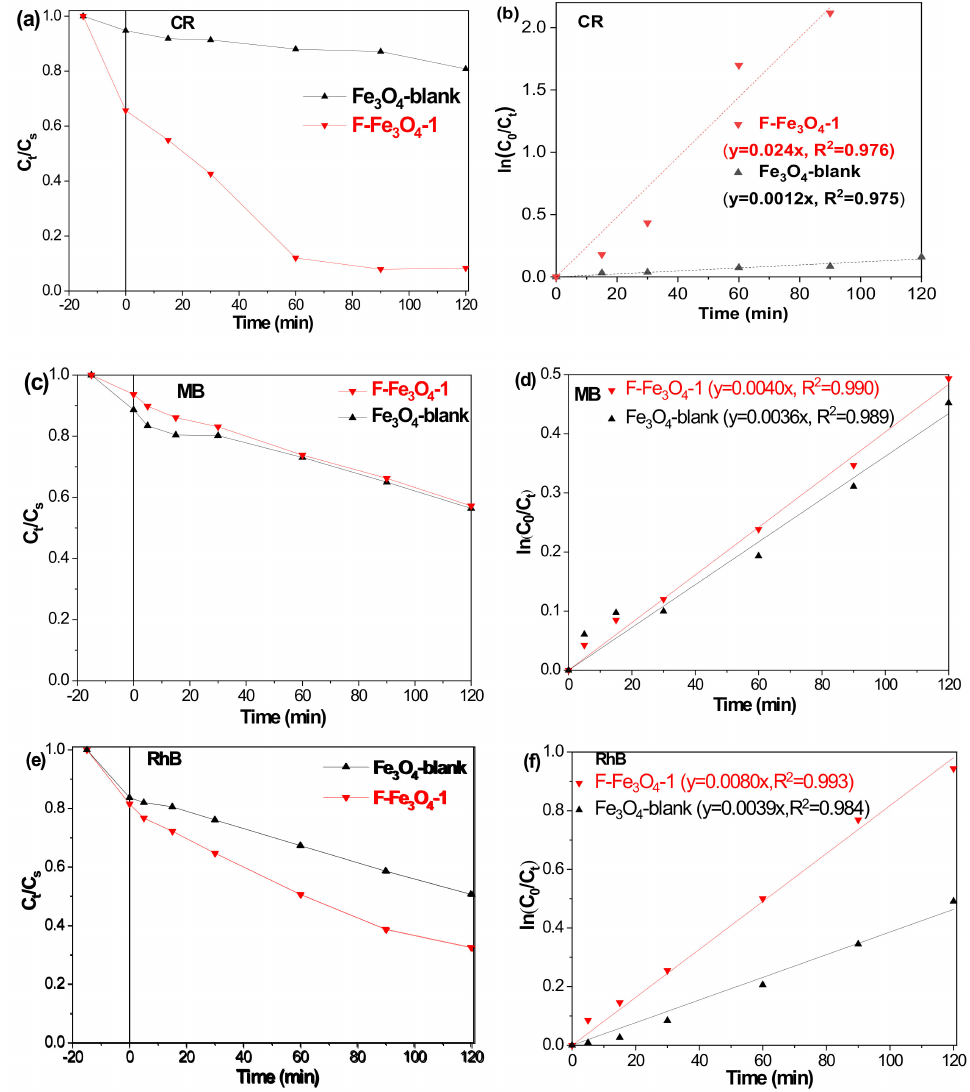
Figure 3. CWPO of organic dyes over F-Fe 3 O 4 -r (r = 0 and 1) microspheres. ( a , c , e ) C t /C s -time plots and ( b , d , f ) ln(C 0 /C t )-time plots. Reaction conditions: CR (100 mg/L, pH 6.8) (MB (0.01 mM, 6.5) or